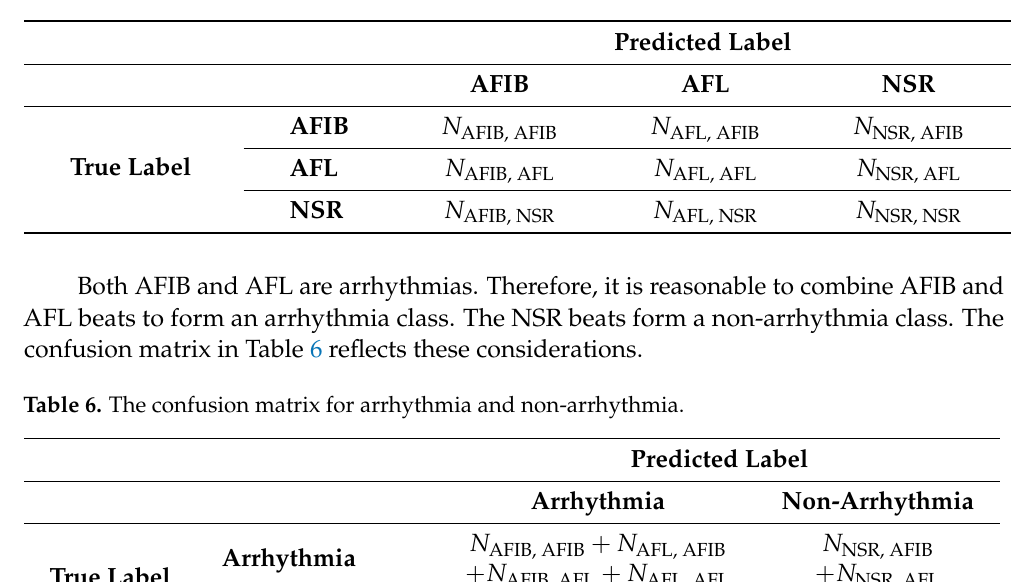
Table 5. The confusion matrix for AFIB, AFL, and NSR.